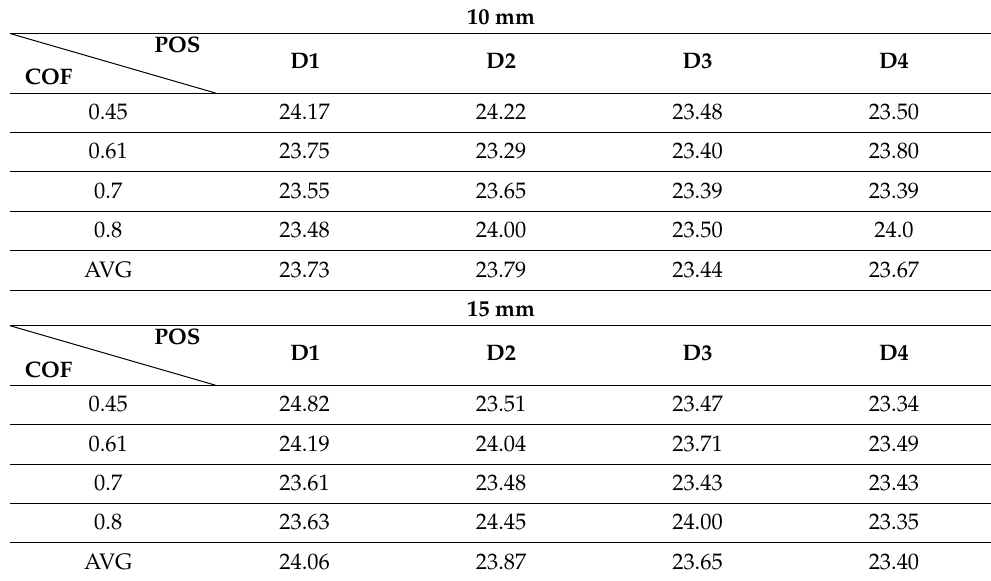
Table 6. Hoop deformation results with hub thicknesses of 10 and 15 mm in method A.